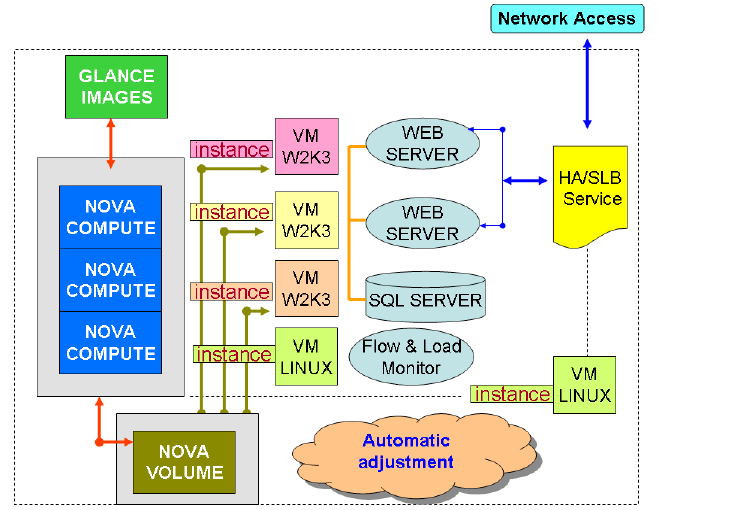
Figure 13. E-book cloud service. System Performance Verification